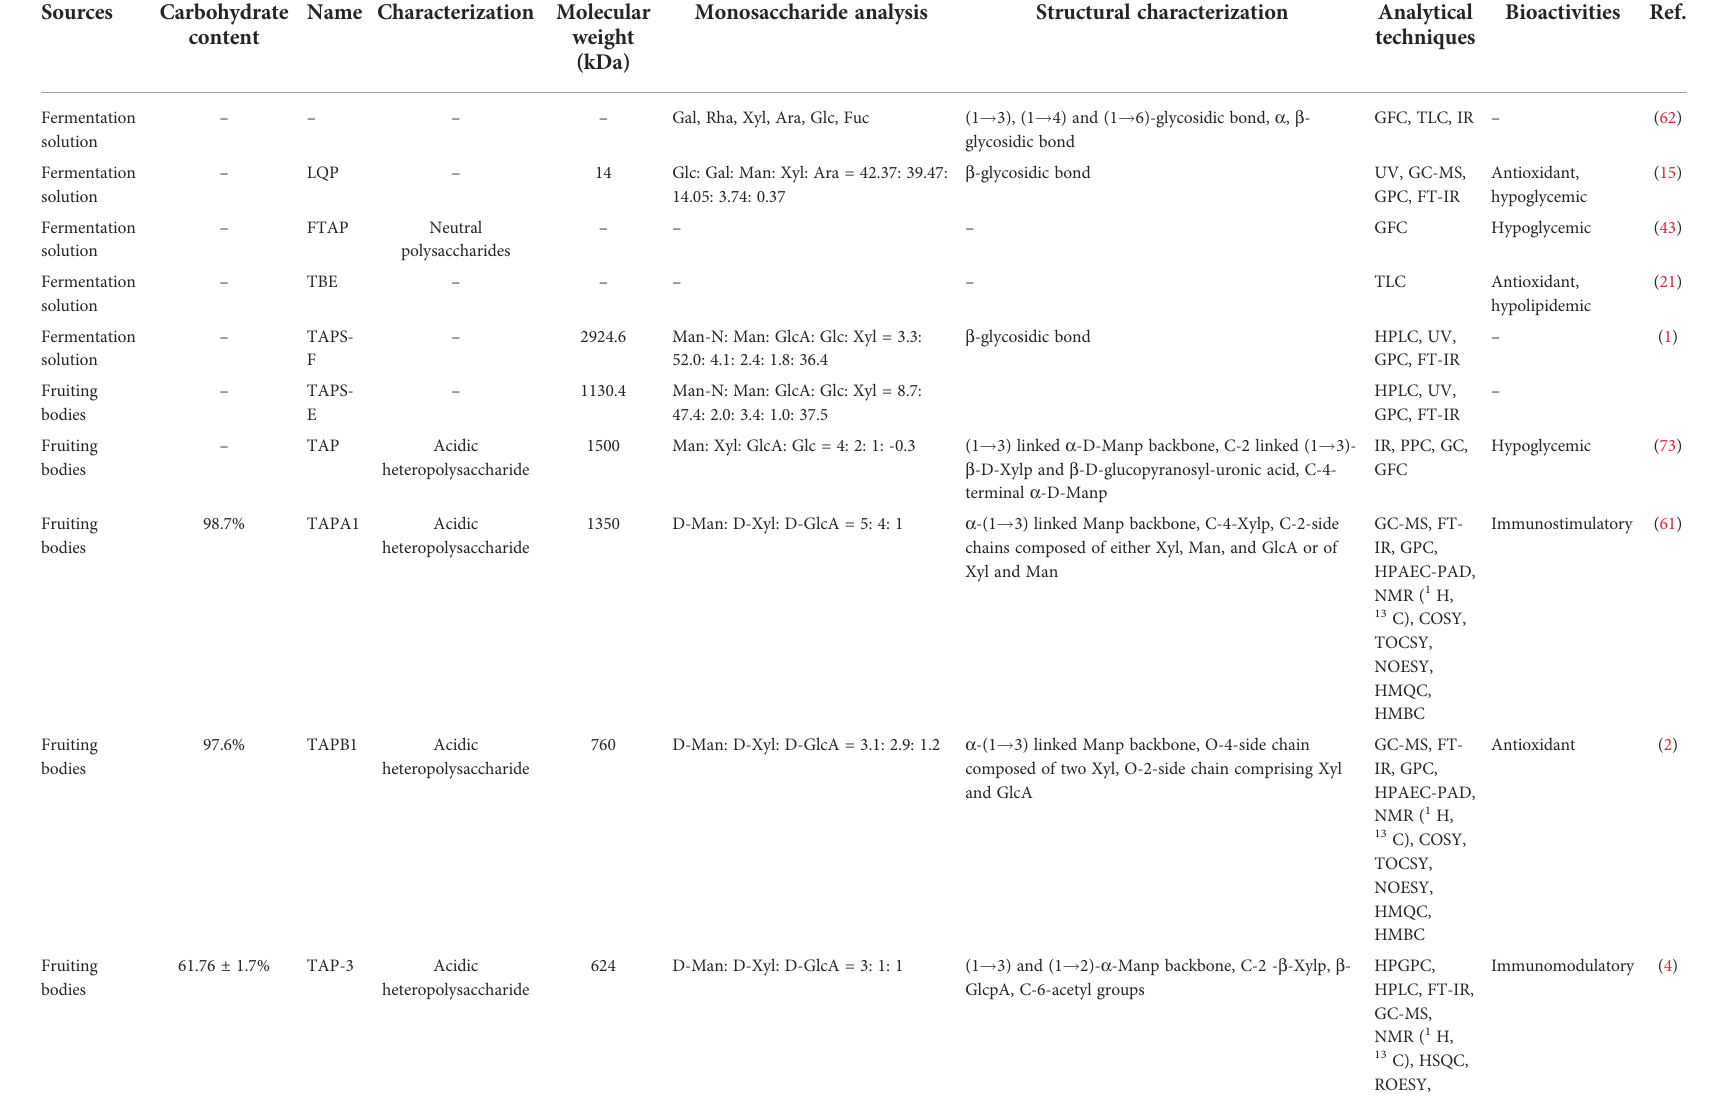
TABLE 2 A summary of the structure of polysaccharides obtained from T. aurantialba